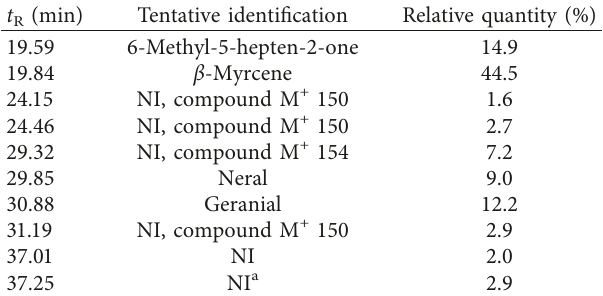
Figure 1: GC-MS chromatogram for lemongrass leaves. Table 1: Presumptive identification and relative quantity (%) of the components present in lemongrass